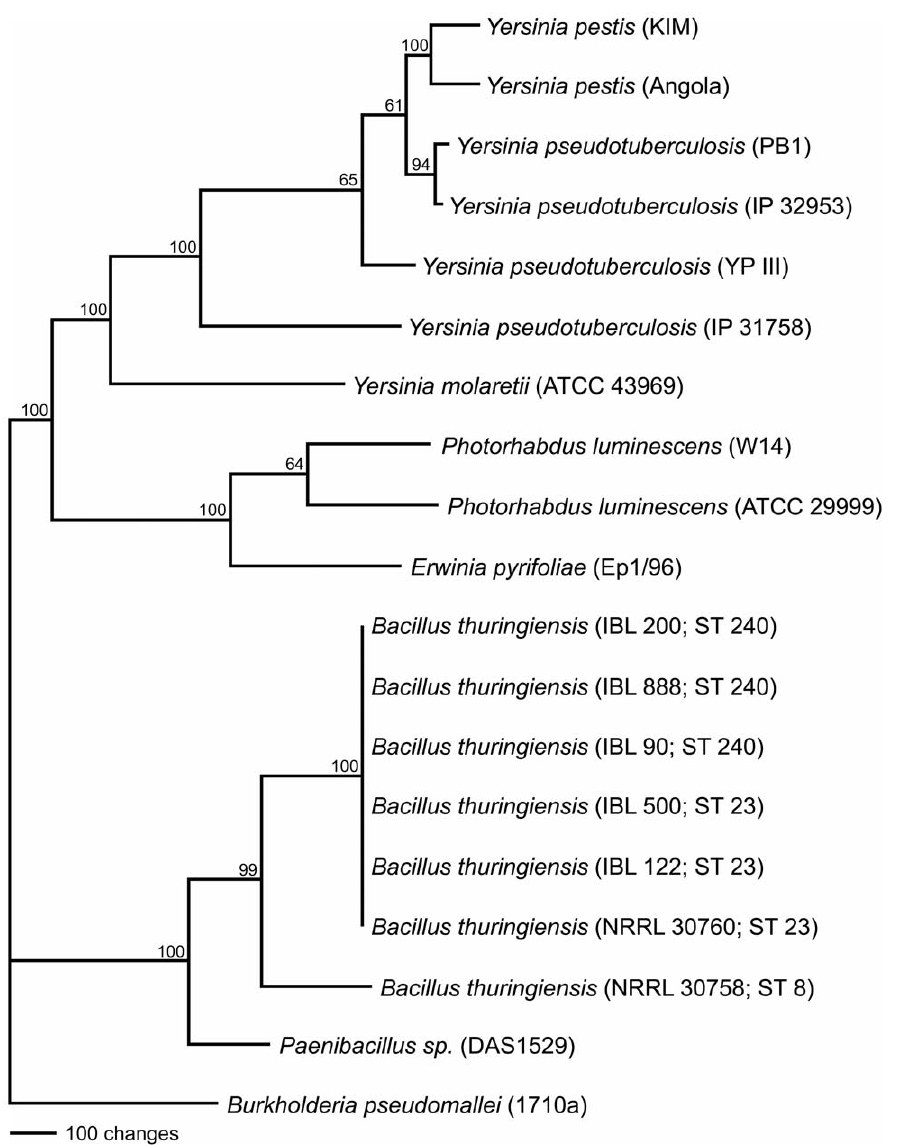
Figure 5. Phylogenetic tree based on TcaC amino acid sequences inferred from tca operons occurring in different bacteria. Only TcaCs encoded within tca operons were included in the analysis (TcaCs encoded in tcd-like operons were not included).